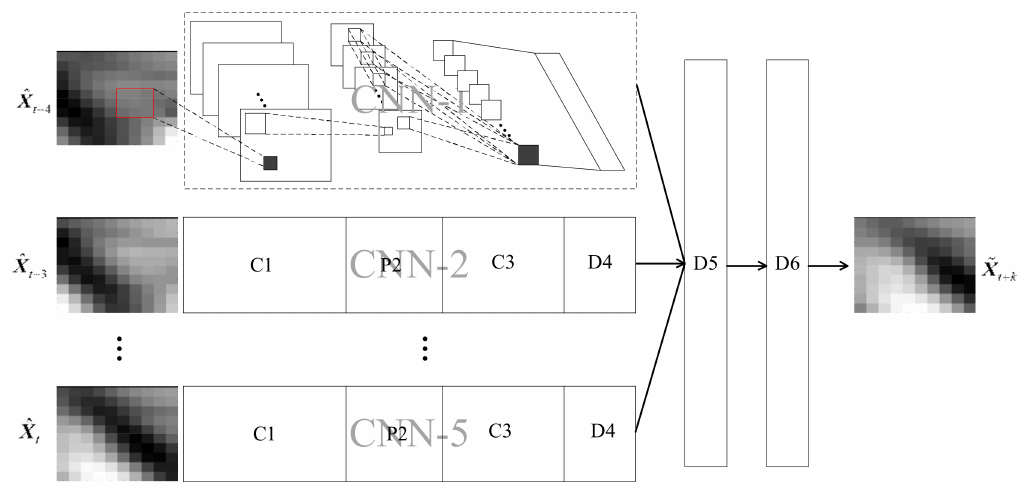
Figure 7. The architecture of